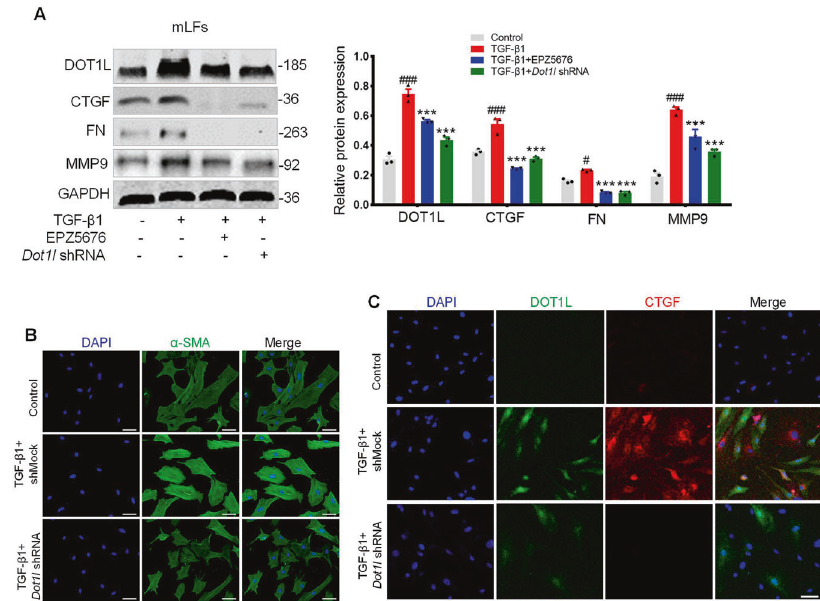
Fig. 5 Blockade of DOT1L inhibits TGF- β 1-induced fi brosis in vitro. mLFs were transfected with Dot1l shRNA for 24 h or pretreated with EPZ5676 (40 μ M) for 4 h and subsequently treated with TGF- β 1 (10 ng/ml). A Immunoblot analysis of DOT1L and lung fi brosis markers (CTGF, FN, and MMP9) in TGF- β 1-induced fi brosis after transfecting with Dot1l shRNA or pretreated with EPZ5676. All data are presented as mean ± S. D. of three independent experiments. # p < 0.05, ### p < 0.001 compared with the control group; *** p < 0.001 compared with the TGF- β 1 group. B Immuno fl uorescence staining of α -SMA, scale bars: 50 μ m. C Immuno fl uorescence double staining of DOT1L and CTGF, scale bars: 50 μ